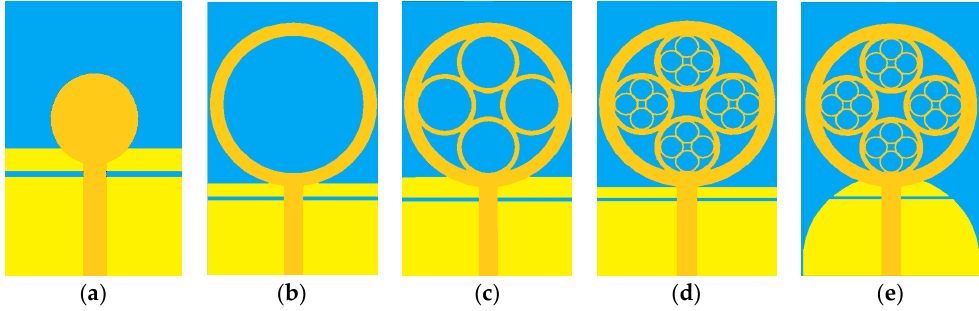
Figure 2. Different development stages: ( a ) initiator, ( b ) Iteration 1, ( c ) Iteration 2, ( d ) Iteration 3, ( e ) Proposed Design.